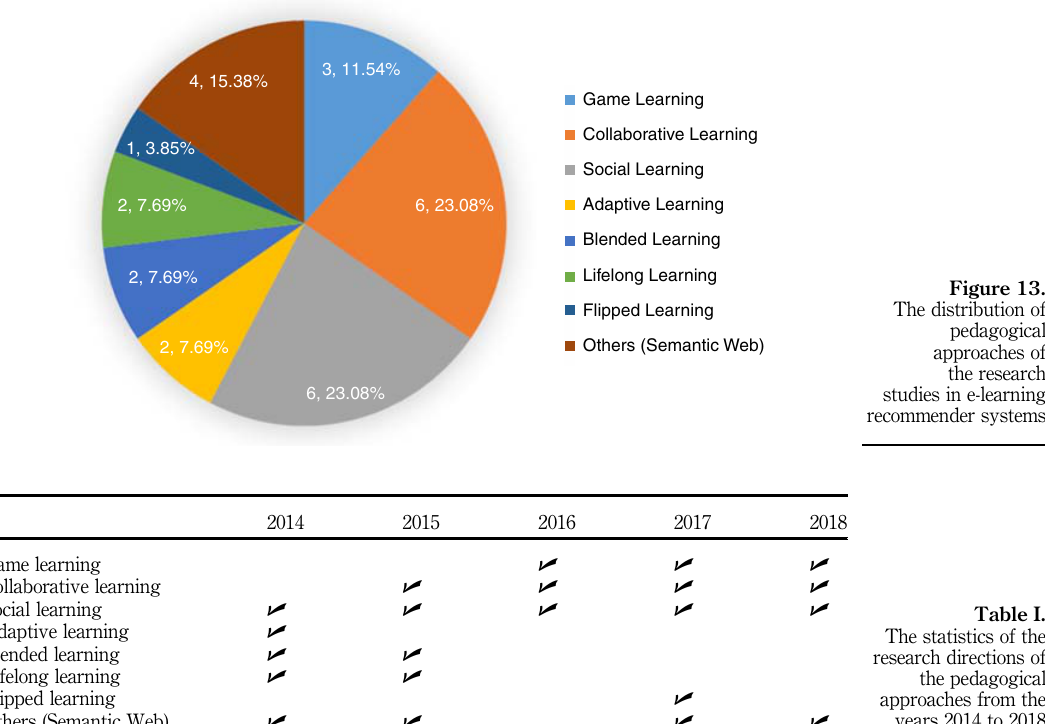
Table I. The statistics of the research directions of the